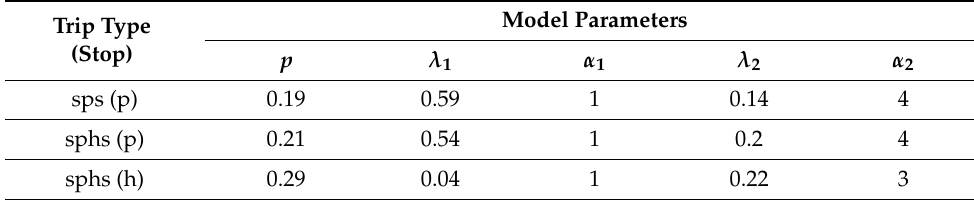
Figure 12. The empirical distribution of provision times. ( a ) Durations of patient treatments in “sps” trips. ( b ) Durations of patient treatments in the “sphs” trips. ( c ) Durations of stops at hospitals in the “sphs” trips. The red line indicates the fit to the data given by Equation (7). Table 4. Parameter values of the distribution function (7) fitted on the Falck dataset.